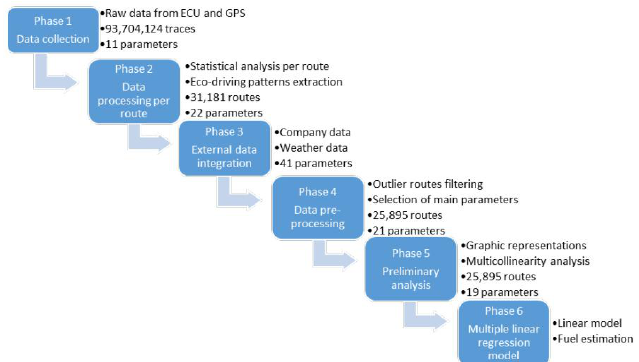
Figure 2. Work Figure 2. Work methodology. Figure 2. Work methodology.